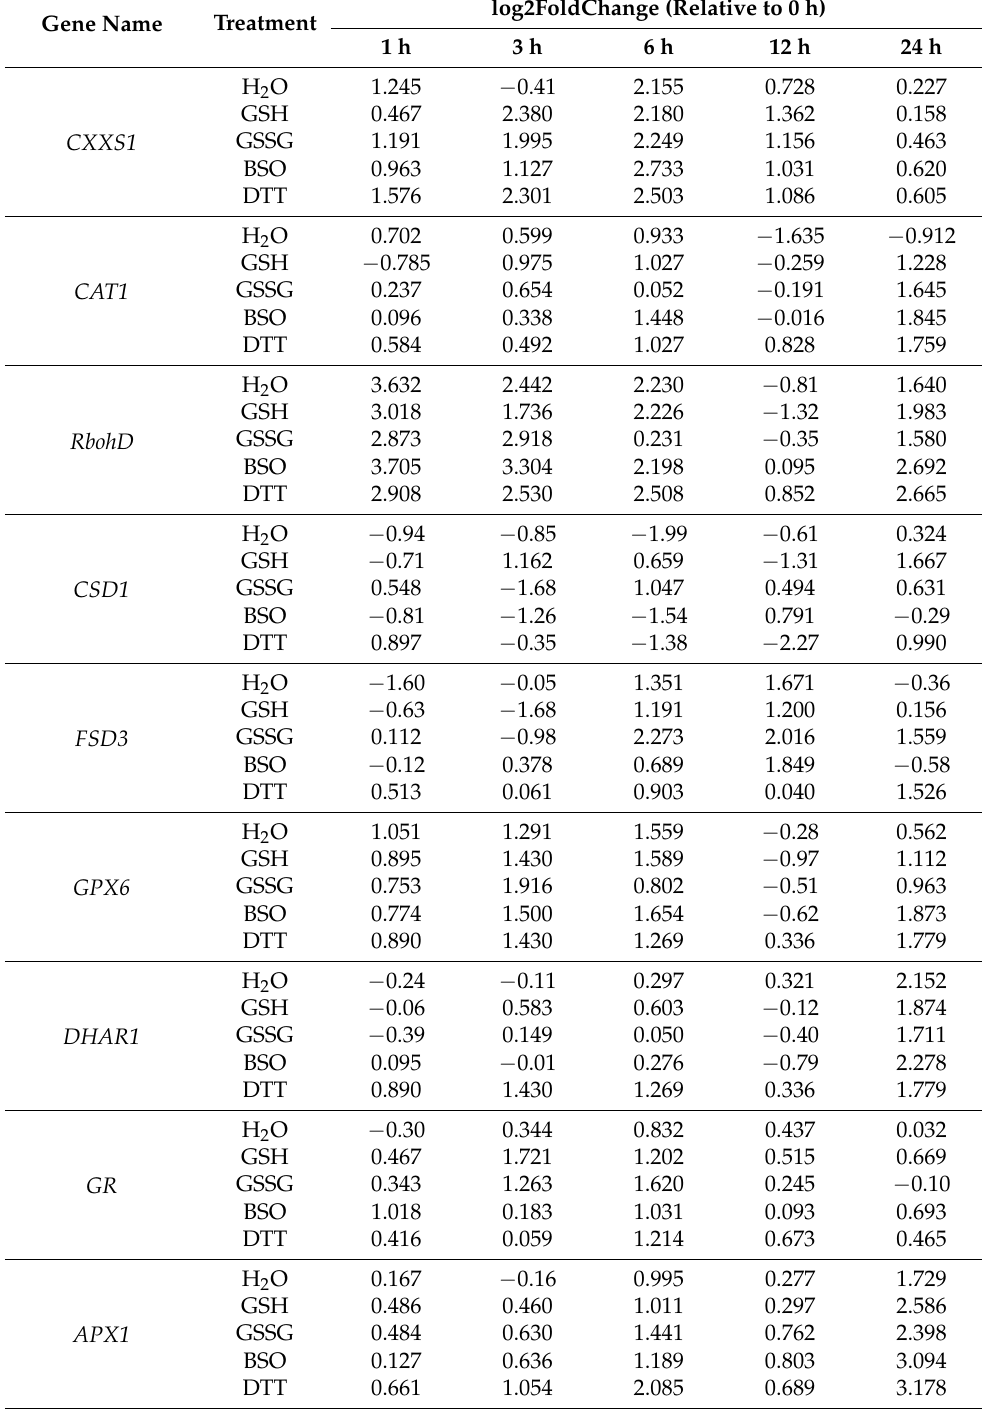
Table 1. Antioxidant-related gene expressions; values are presented as L2FC relative to CK (0